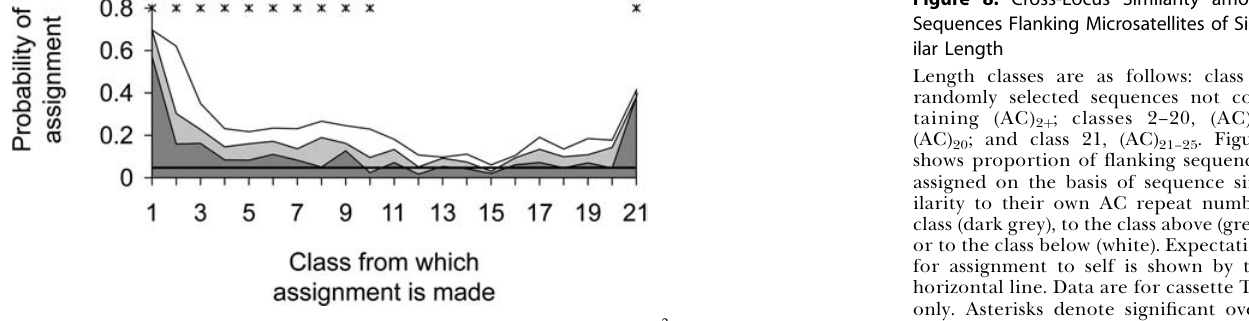
Figure 8. Cross-Locus Similarity among Sequences Flanking Microsatellites of Sim- ilar Length